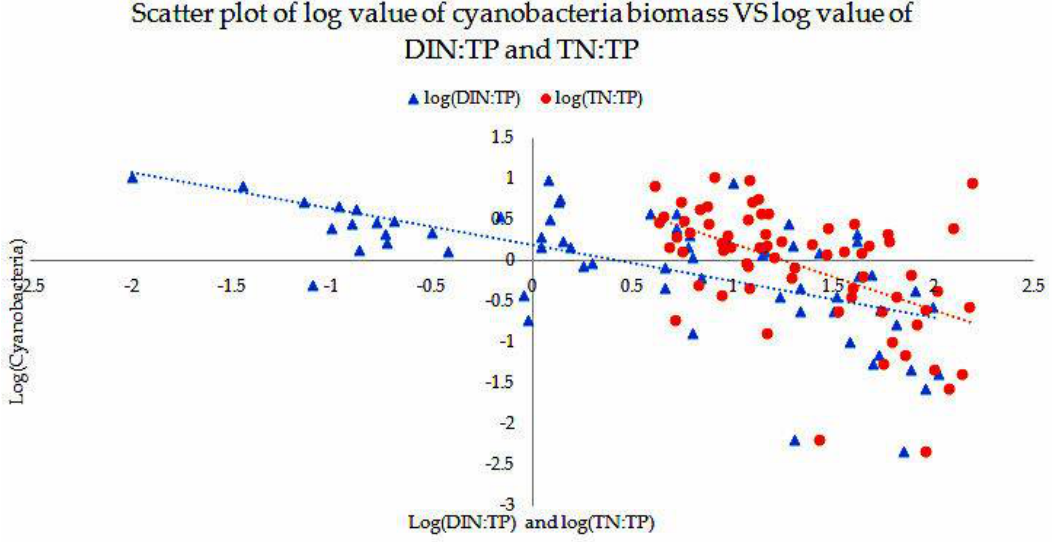
Figure 5. Comparison of the relation of DIN:TP with cyanobacteria biomass (triangle blue) and TN:TP with cyanobacteria biomass (dot red).